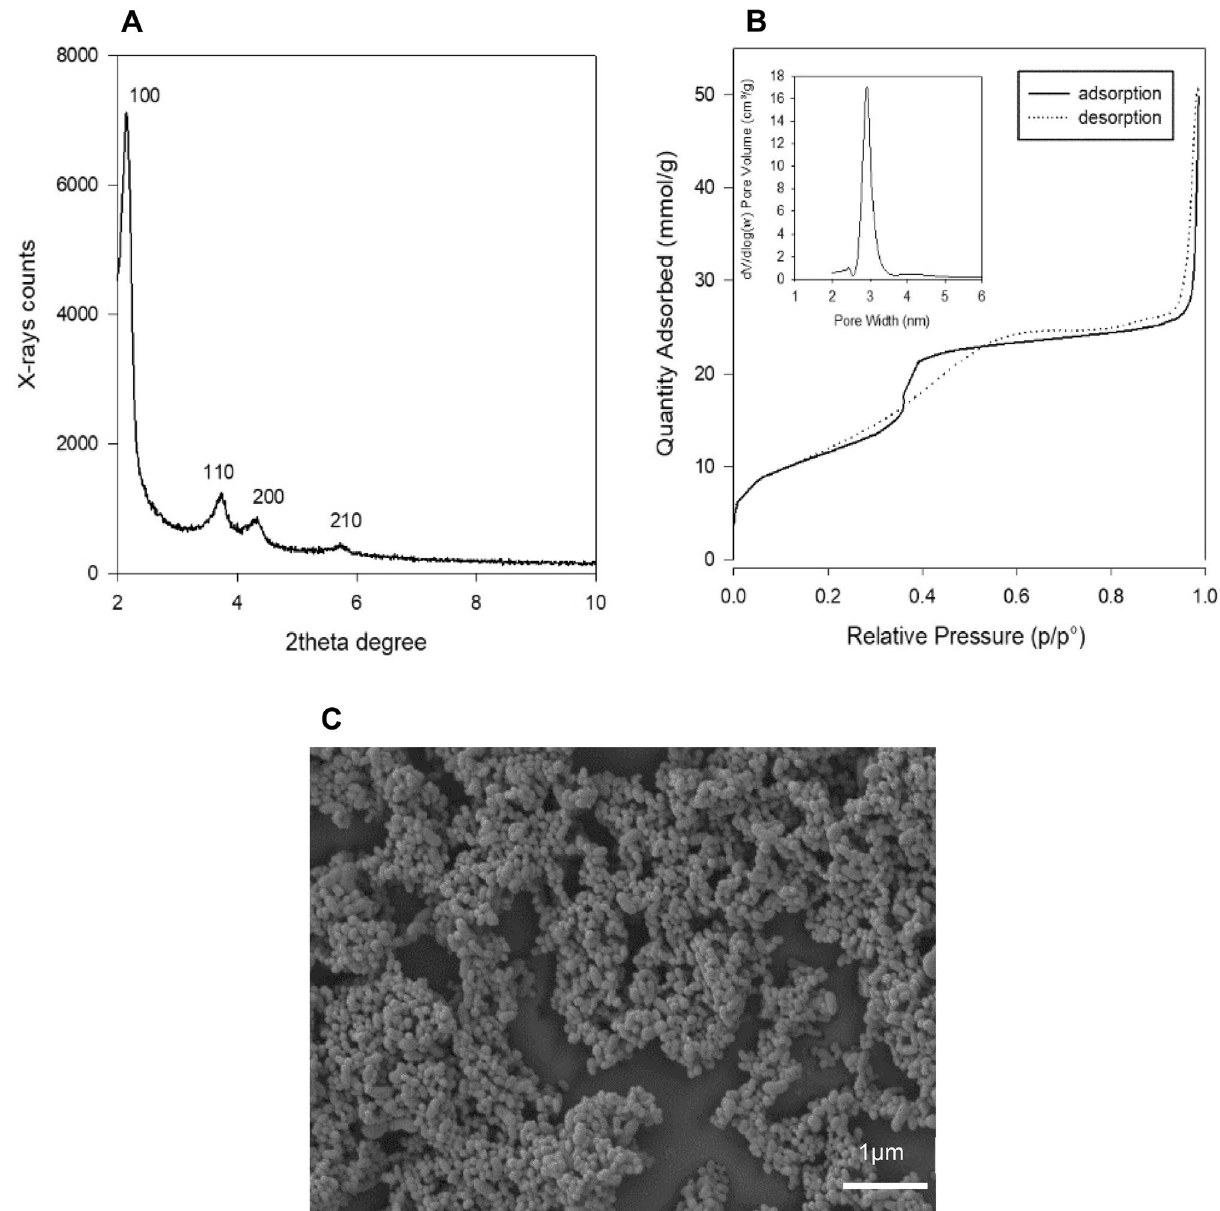
Figure 2. MSN structural and textural characterization. The nanoparticles were characterized to determine the hexagonal pore organization, pore volume and size, surface area and morphology. ( A ) Powder X-ray diffraction pattern at low angle of MSN. ( B ) N 2 adsorption–desorption porosimetry isotherm, and pore size distribution (inset). ( C ) Scanning electron microscopy (SEM) image of the These results show that PEGylation did not impair nanoparticle internalization by U-87 cells after 24 h in contact with the cells. This is supported by previous observations with PEGylated PLGA-based nanoparticle internalization on HeLa cells verified by flow cytometry (up to 24 h incubation) 31 , brain endothelial cells uptake of PEGylated silica nanoparticles observed by confocal fluorescence microscopy (4 h incubation) 43 or MSN functionalized with PEG through a disulphide bond internalized in MCF7 cells after 24 h incubation 44 . The successful formation of a responsive gate on the MSN pores after PEGylation was confirmed by the release assays presented in Fig. 6A,B. The release of Safranin-O was used to test the effectiveness of the molecular gate in a preliminary assay. As observed in Fig. 6A, the release of Safranin-O was triggered after the GSH addition. This effect was reproduced in the PTX release study from MSN-PEG (Fig. 6B) as compared to a negative control without the addition of GSH, and the non-PEGylated MSN (positive control). The basal release from MSN-PEG was around 15% of the maximum release over the time of the experiment, and these nanoparticles released almost 40% when the stimulus was added. This type of redox-responsive molecular gates have been previously described and applied against a range of tumours 25,44,45 .